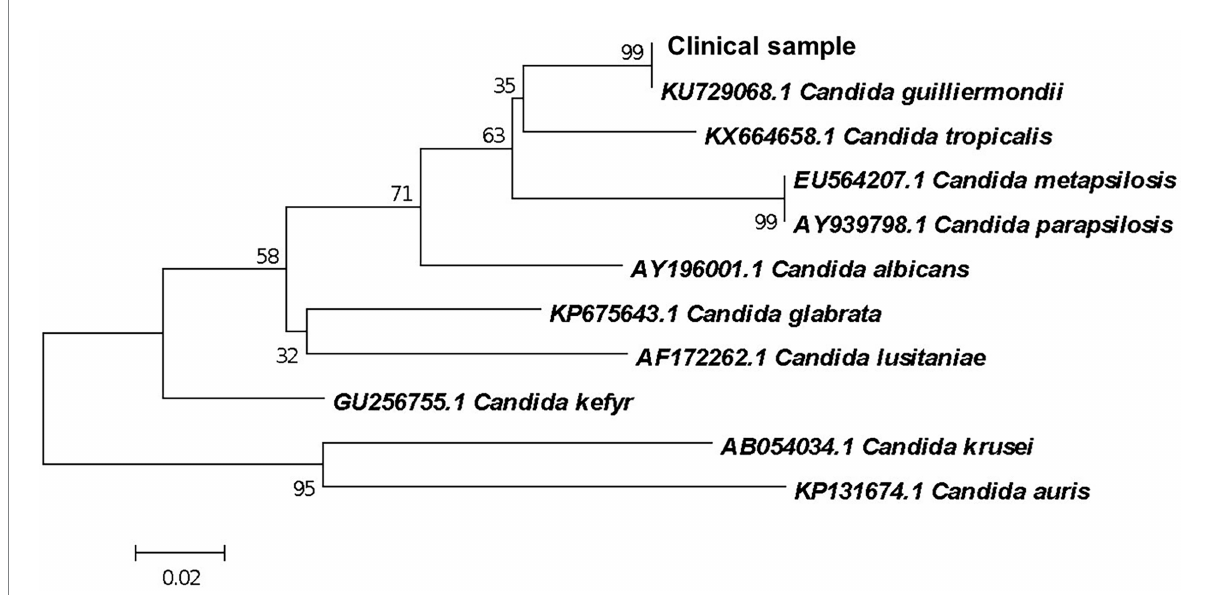
FIGURE 3 Phylogenetic relationship between the clinical isolate and reference strains of Candida species inferred from ITS sequences by Neighbor-Joining method (Saitou and Nei, 1987). The optimal tree is shown. The percentages of replicate trees in which the associated taxa clustered together in the bootstrap test (1,000 replicates) are shown next to the branches (Felsenstein, 1985). Branches corresponding to partitions reproduced in less than 50% bootstrap replicates are collapsed. The evolutionary distances were computed using the Maximum Composite Likelihood method (Tamura et al., 2004) and are in the units of the number of base substitutions per site. This analysis involved 11 nucleotide sequences. There were a total of 78 positions in the final dataset. Evolutionary analyses were conducted in MEGA X (Tamura et al.,